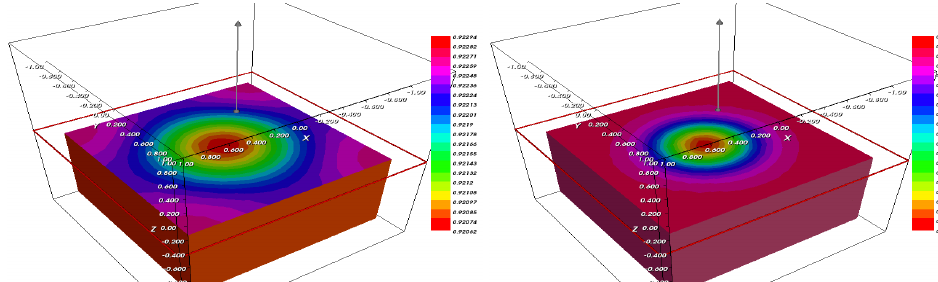
Figure 18. The fraction ϕ ( left ) and ψ ( right ) after T = 40.